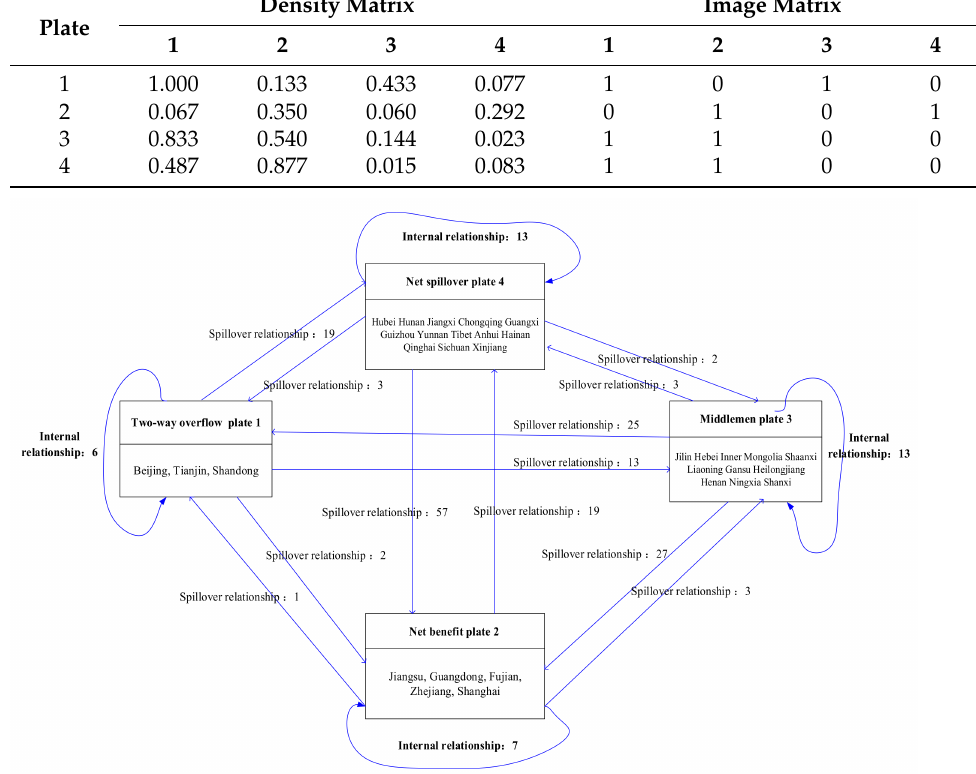
Figure 4. The transfer relationship among the four major plates of correlation network.